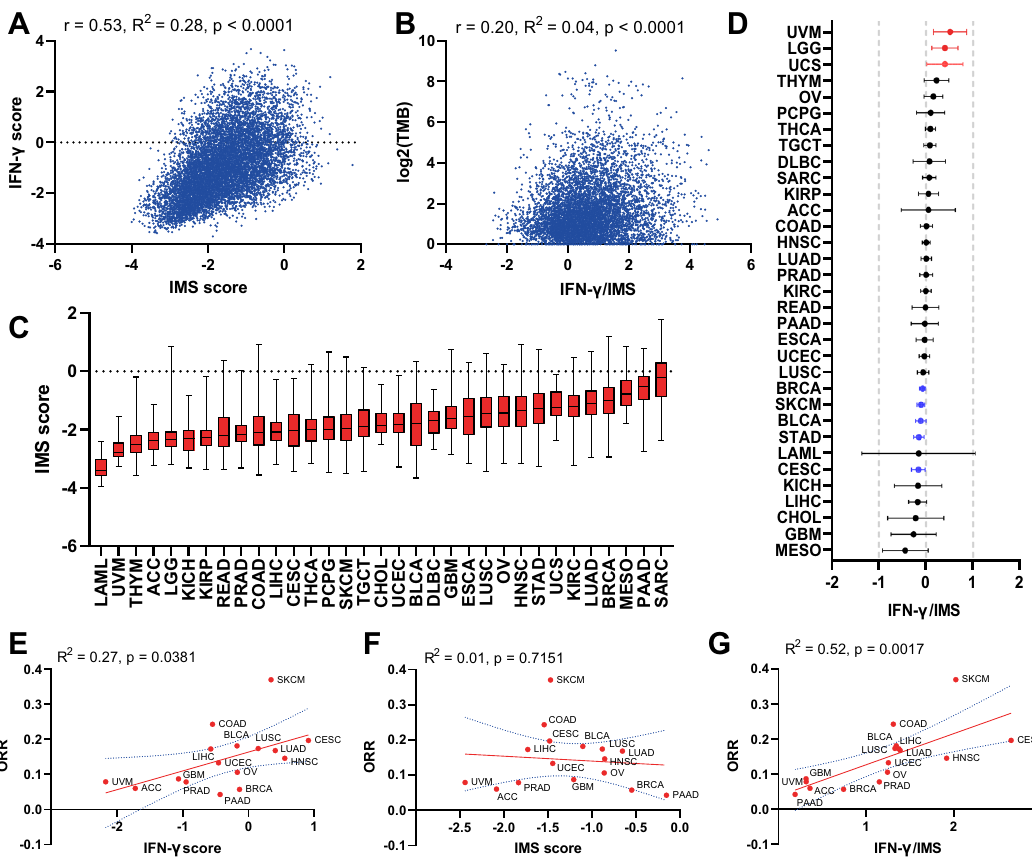
Fig. 3 Balance between the INF- γ signature and IMS as a biomarker for cancer. A Pearson correlations of IMS score with the IFN- γ signature ( r = 0.54, R 2 = 0.28, p < 0.0001) for all TCGA patients ( n = 11,043). B Pearson correlation of logTMB with IFN- γ /IMS ratio ( r = 0.20, R 2 = 0.04, p < 0.0001) for all TCGA patients ( n = 11,043). C , Boxplots showing a summary of the distribution of IMS scores for all TCGA patients, with tumor types ordered by their median IMS score. D , Log hazard ratio estimates and 95% con fi dence intervals, with adjustment for sex (Female versus Male), age ( ≥ 60 versus < 60), and TMB with a binary cutoff (top 20% of each cancer type). Cancers in which the IFN- γ /IMS ratio was statistically signi fi cantly ( p < 0.05) associated with good prognosis are highlighted in blue; signi fi cant associations with poor prognosis are in red. E – G Associations of the ORR to immunotherapy for different cancer types with their median IFN- γ signature (linear regression goodness - of- fi t R 2 = 0.27, p = 0.381; in E ), IMS ( R 2 = 0.01, p = 0.715; in F ), and IFN- γ /IMS ( R 2 = 0.52, p = 0.017; in G ) values in the TCGA